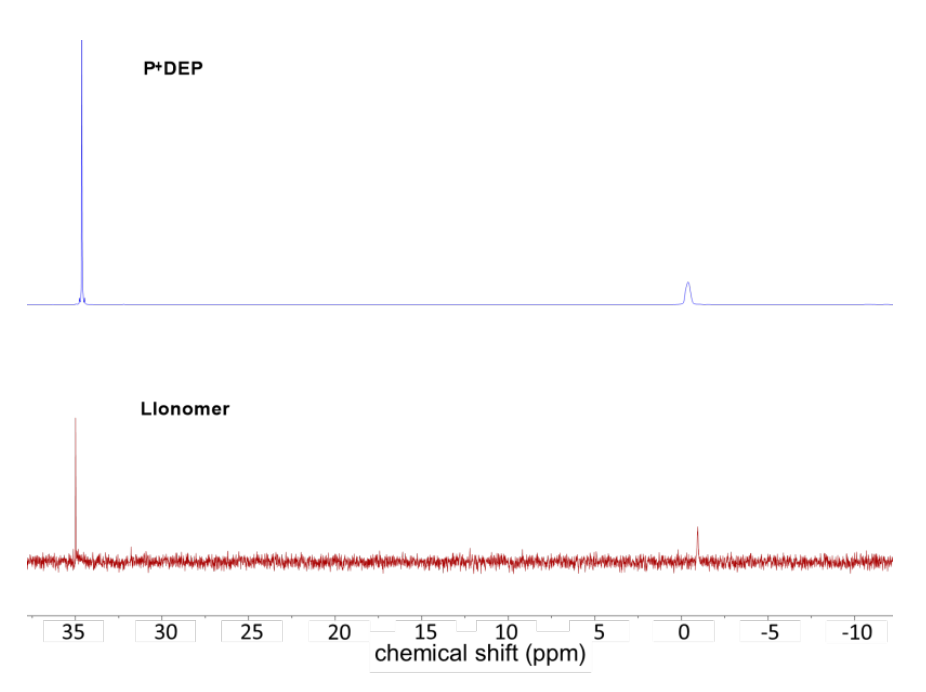
Figure 4. 31 P NMR spectra (400 MHz; C 6 D 5 Cl solvent) of neat ILs and LIonomers (10 wt.%